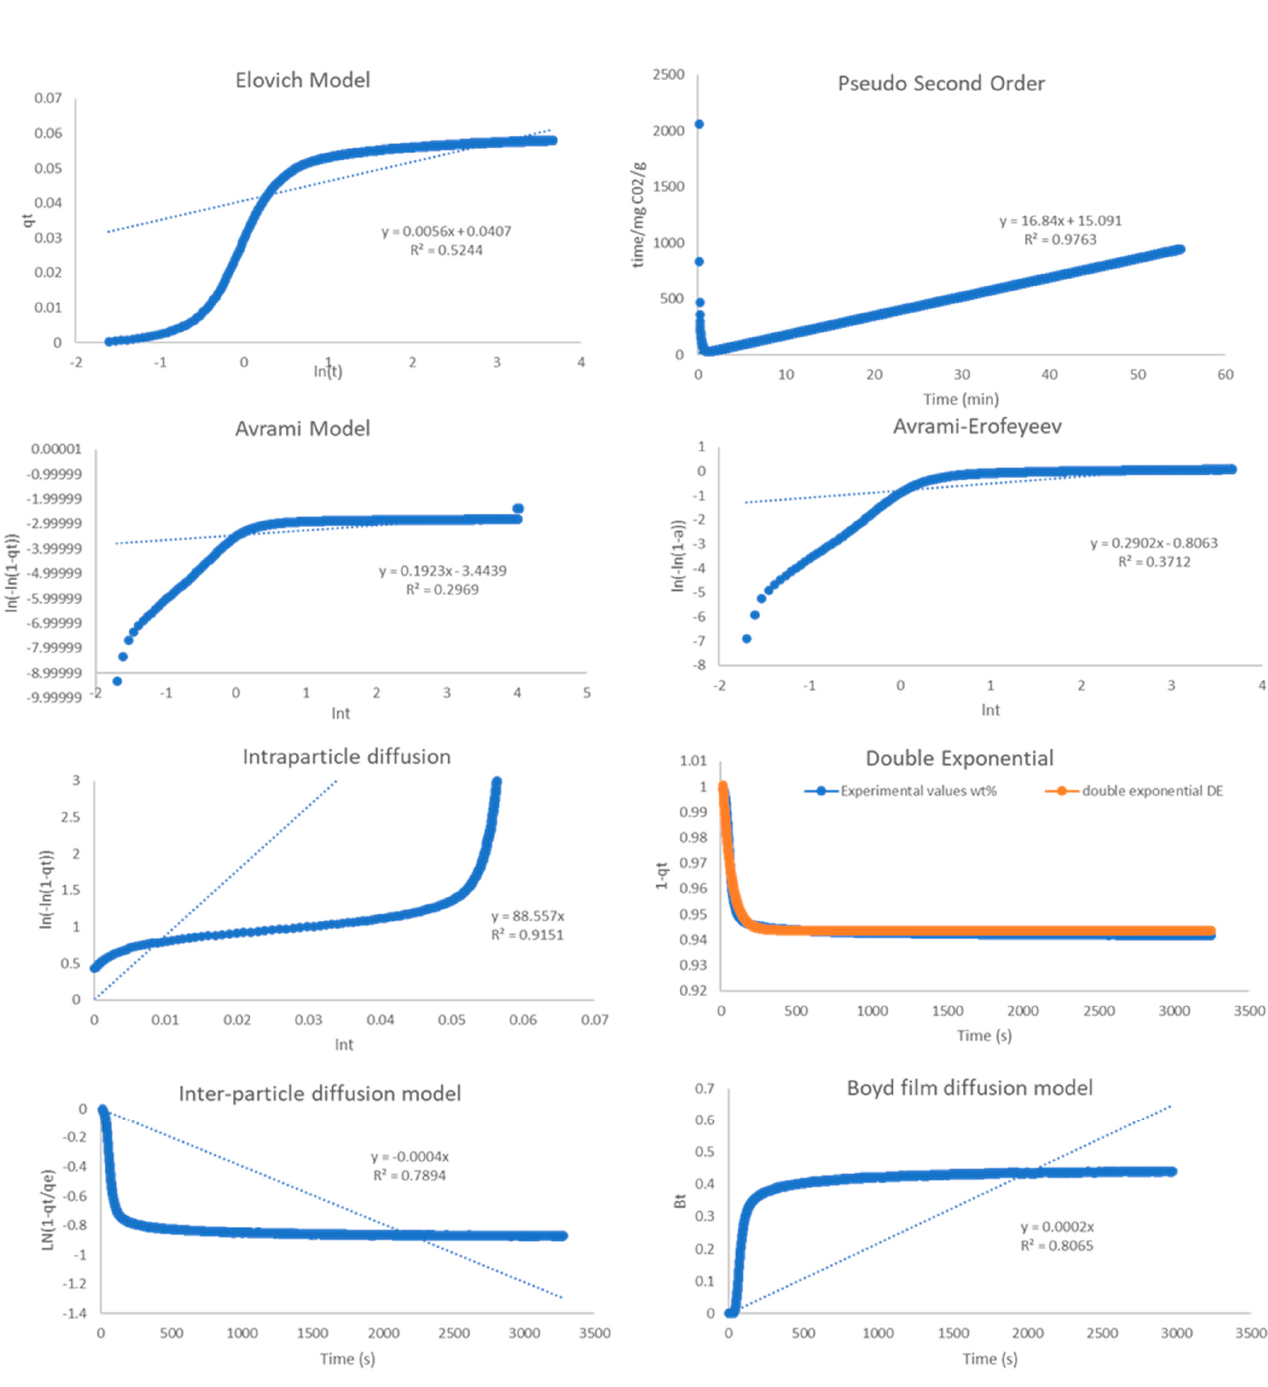
Figure A6. Kinetic modelling at 900 °C.